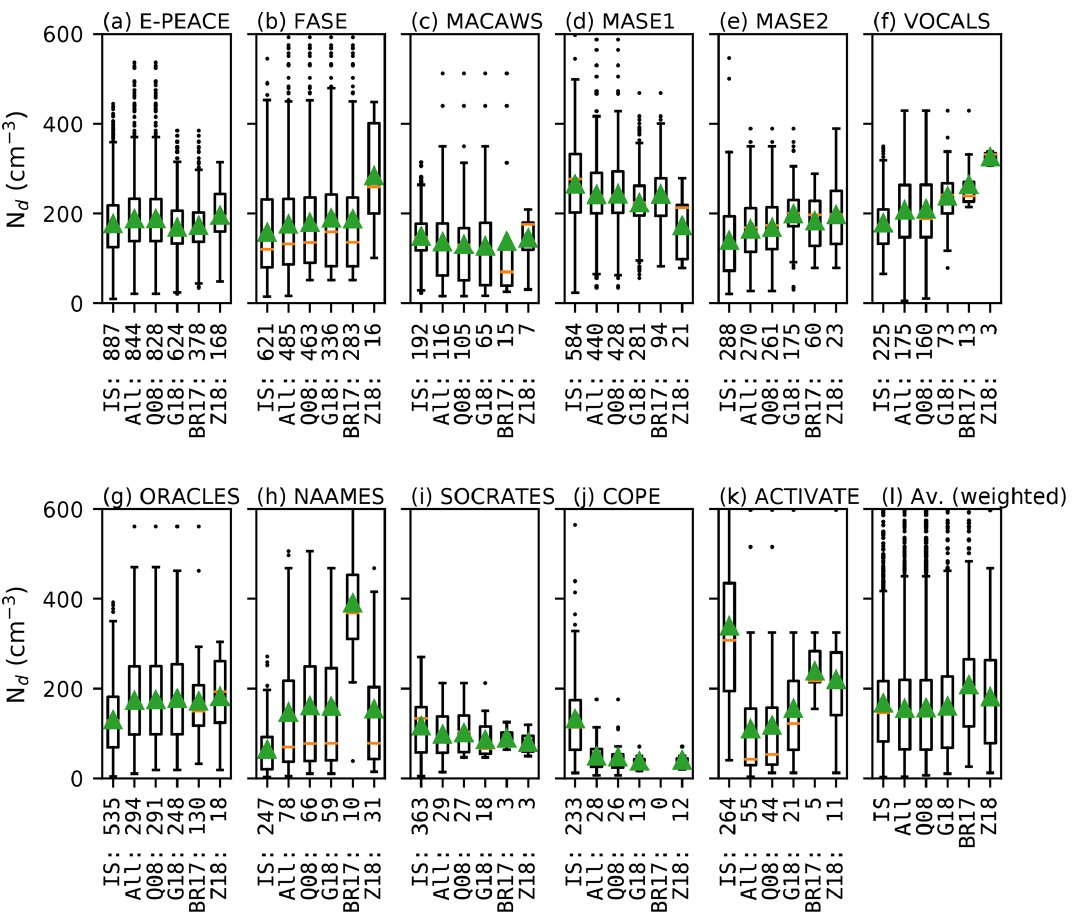
Figure 6. Comparison between the MODIS and in situ N d distributions for each campaign. In each subplot, the in situ distribution is the left-most boxplot, composed of all the valid in situ data points with a coincident (within 30min) satellite view (from either Aqua or Terra), independent of whether there is a valid retrieval. Green triangles are the mean, and orange lines are the median. The other boxes in each subplot are the distributions of valid satellite N d retrievals for each sampling strategy that are coincident with aircraft measurements. The number of N d data points for each boxplot is given below the x axis; (l) is the average of all campaigns (equally